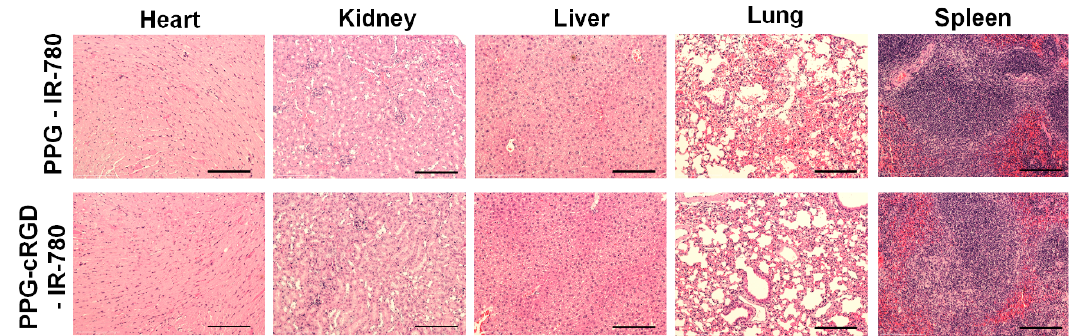
Figure 9. H&E staining of major organs analyzed at 72 h post-injection of nanoparticle formulations. Scale bar: 200 µm.